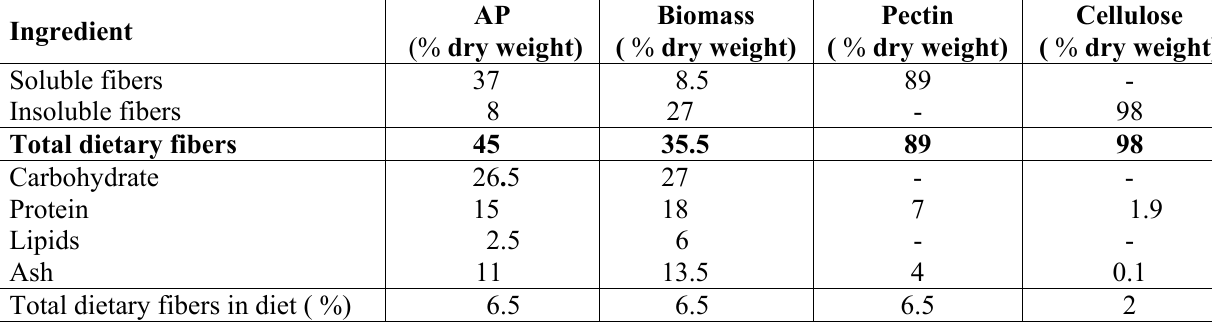
Table 1. Composition of the algal polysaccharide (AP), biomass, pectin and cellulose fiber sources.